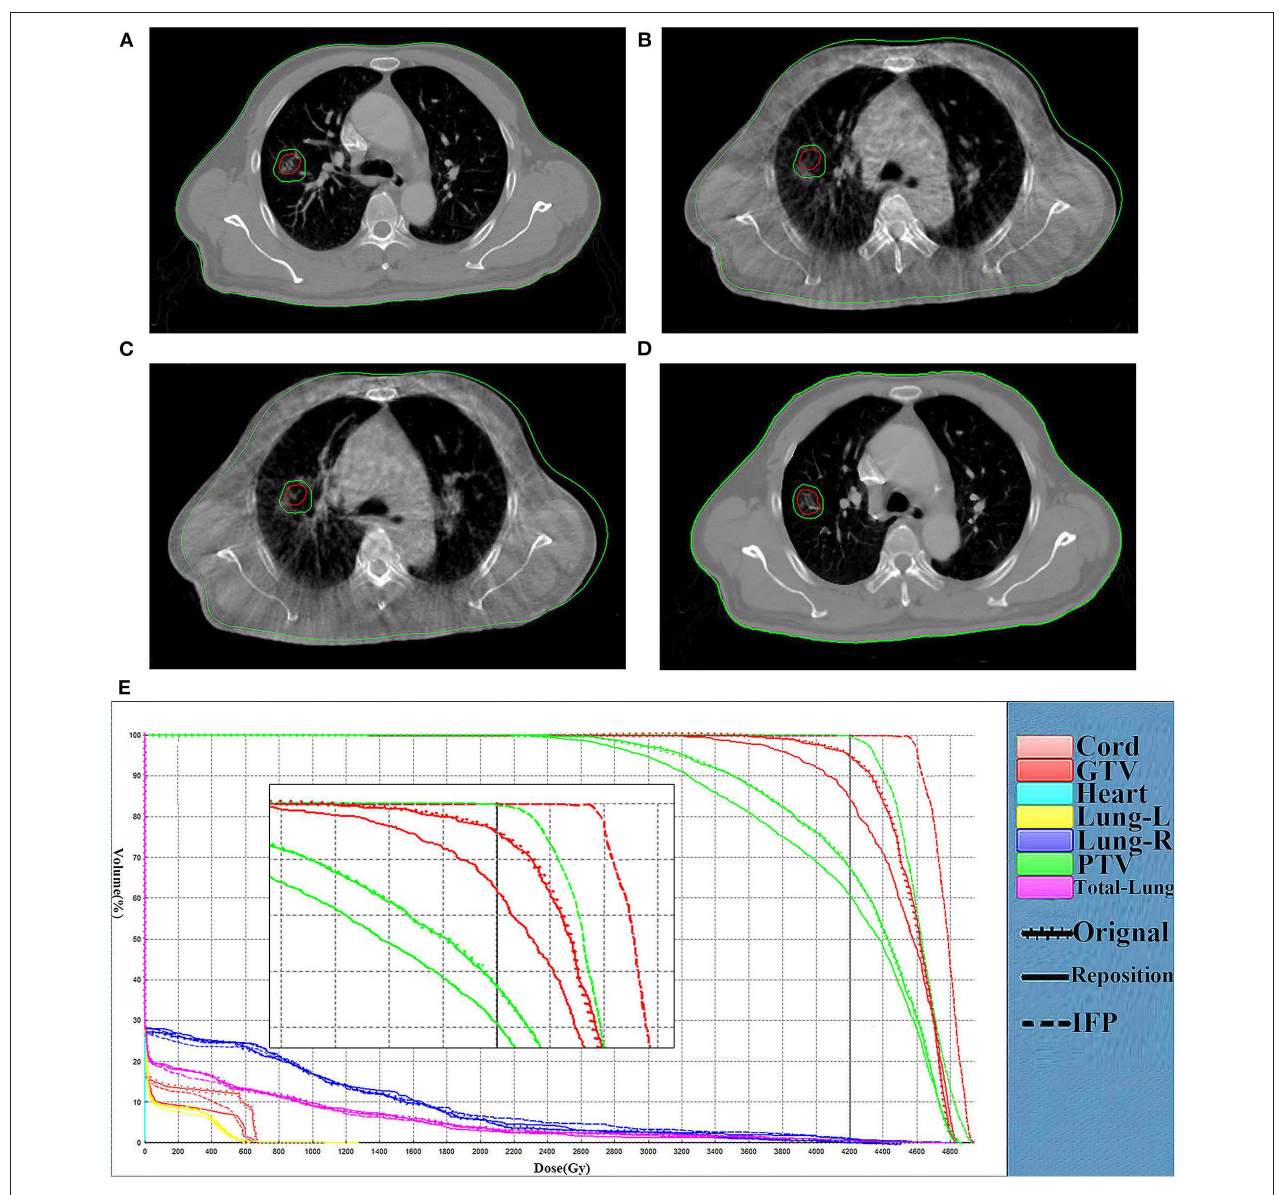
FIGURE 5 | Comparison of representative CT slices. Comparison of representative CT slices obtained on the planning CT (A) , the CBCT before shift couch (B) , the CBCT after shift couch (C) , and the corrected CT image (D) as well as DVH curves comparison (E) of the same fraction for a lung cancer patient. The dotted, dashes, and solid curves represent the original, IFP and the repositioning plans,